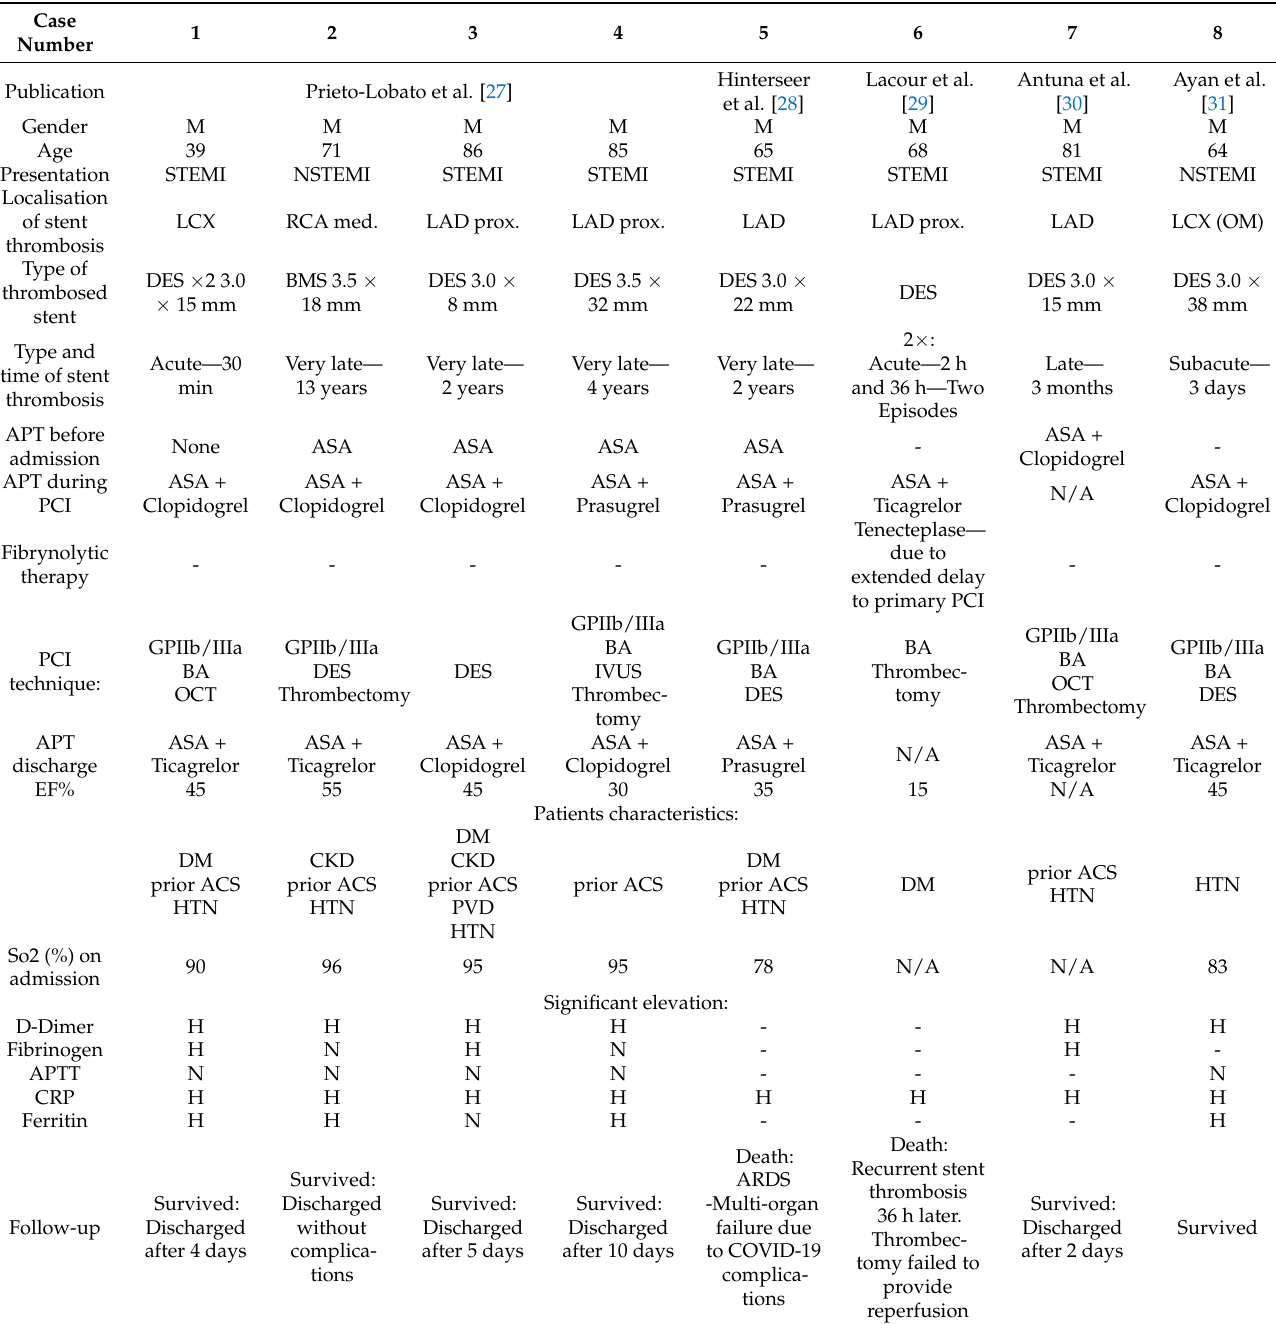
Table 2. Patients characteristics and procedure specifications.